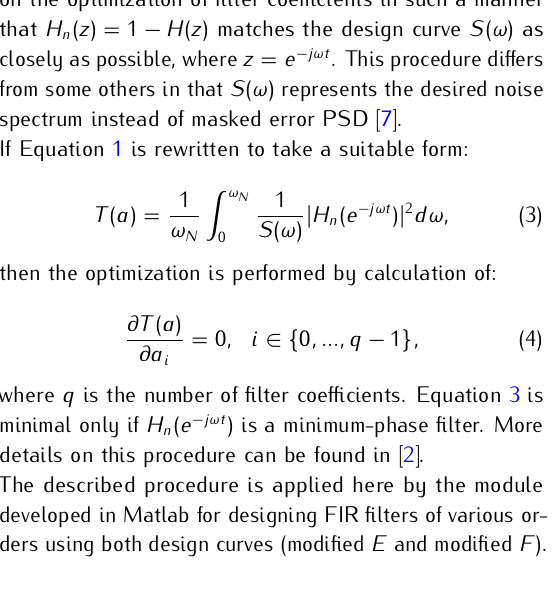
where W ( ω ) is the perceptual weighting function, ω = 2 πf ( f is the frequency), and ω N = 2 π ( f s / 2), where f s is the sampling frequency whose value is typically 44 . 1